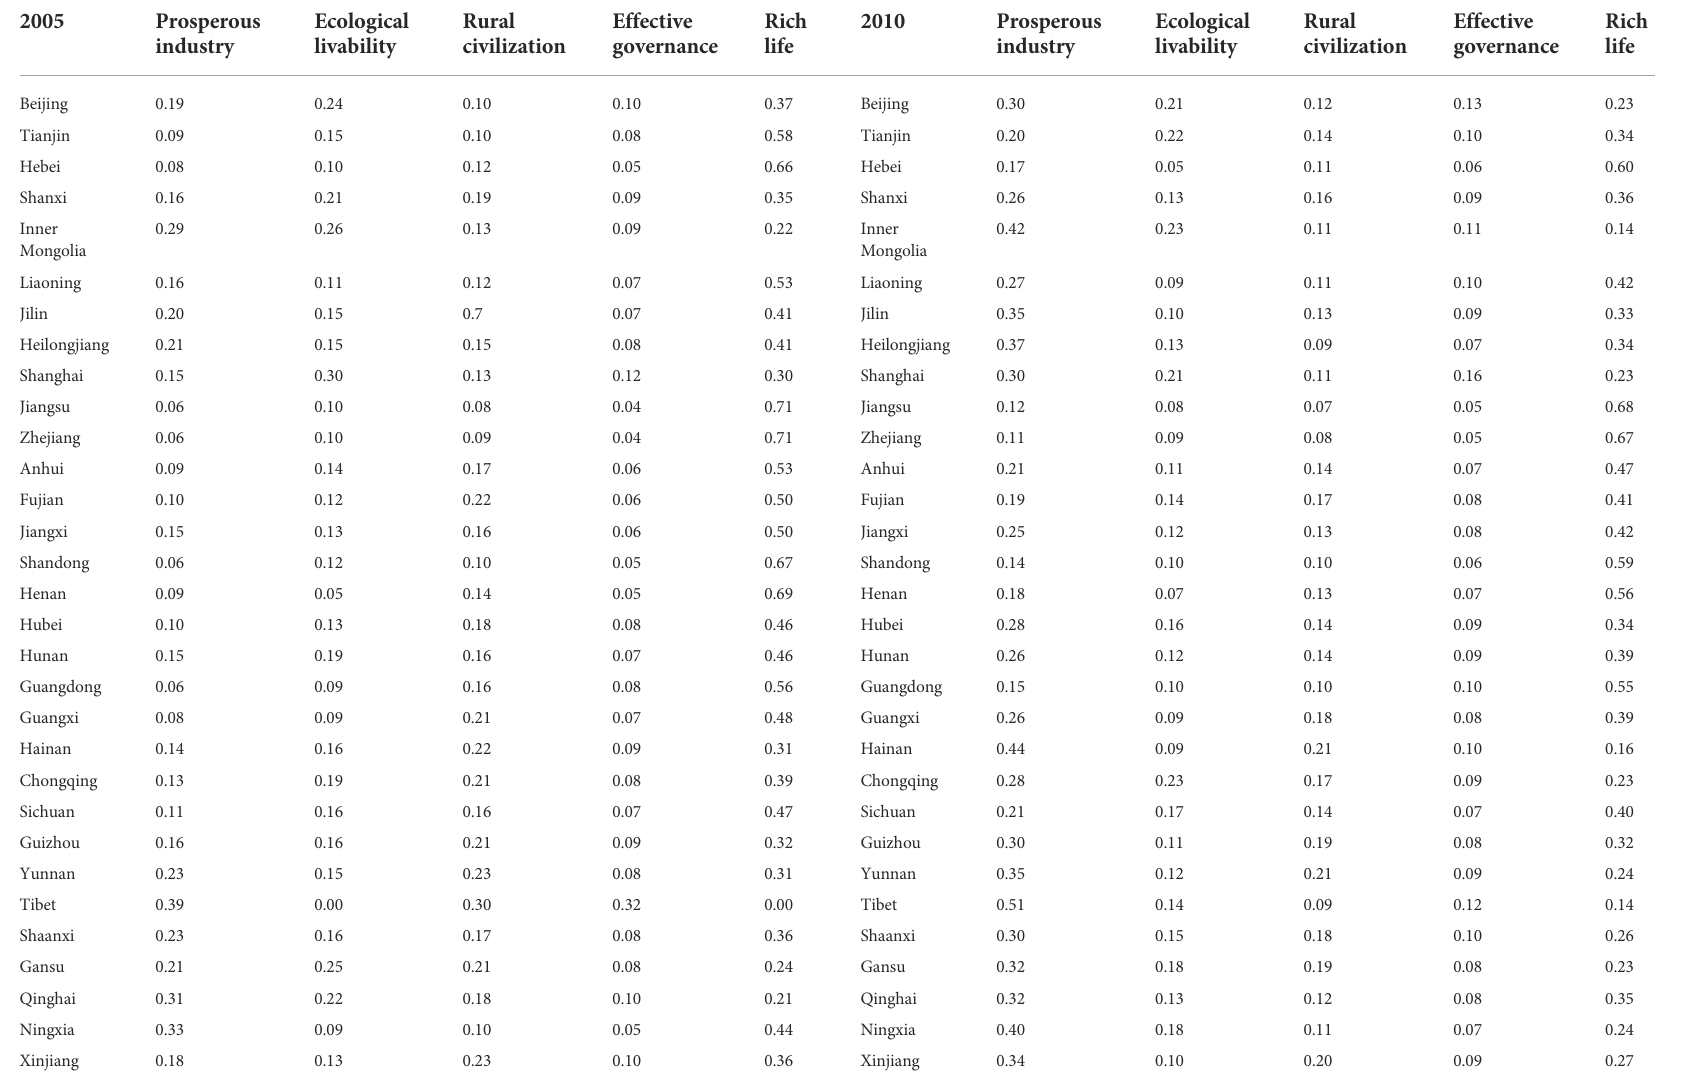
TABLE 7 Calculation results of each dimension proportion of 31 PLAD in 2005 and